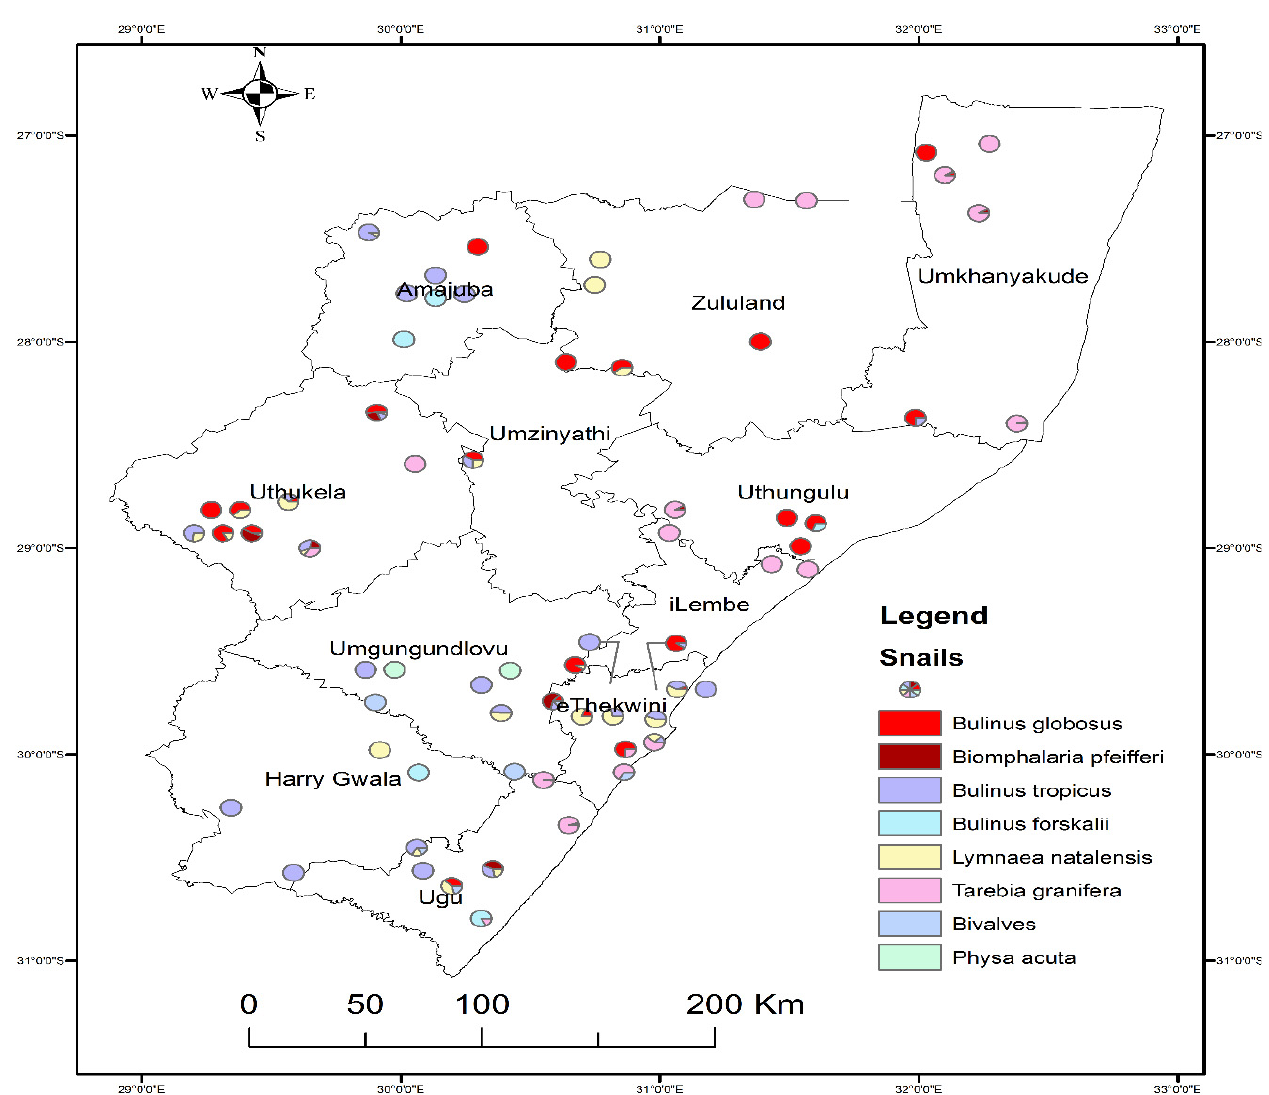
Figure 1. Map of KZN province showing locations where snails were found according to species.